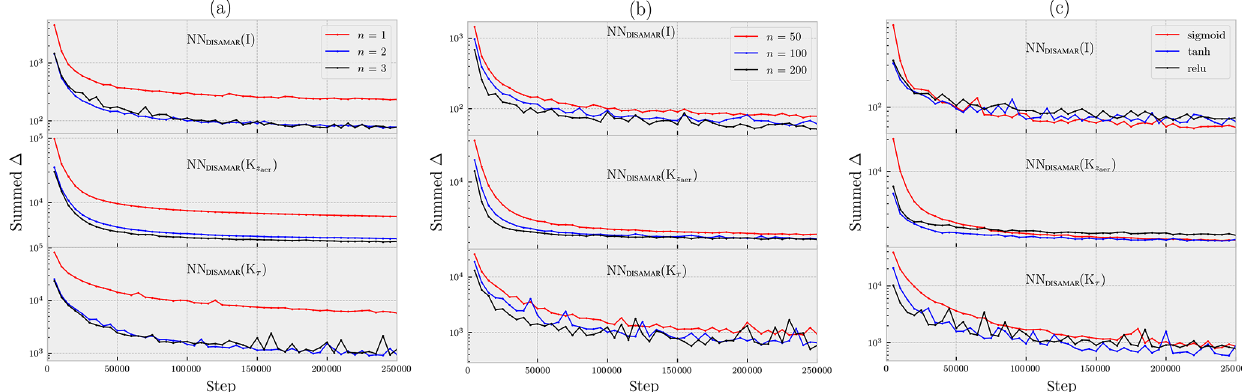
Figure 2. Summed loss as a function of training step for different neural network model configurations. (a) The neural network models have 50 nodes per layer with a sigmoid activation function. (b) The neural network models have two hidden layers with each node activated by the sigmoid function. (c) The neural network models have two hidden layers with 100 nodes for each layer.